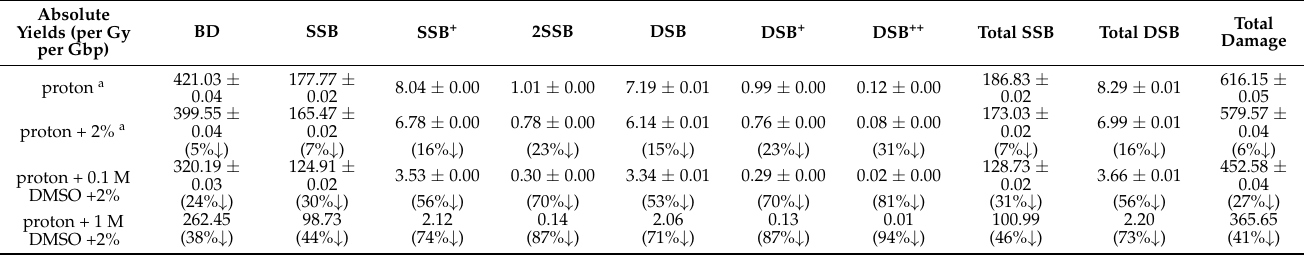
Table 3. Absolute Yields of DSB Inductions for Cells Irradiated with Proton Ions (LET = 1.051 keV/ µ m) under 2% Oxygen (O 2 ) and at Various Concentrations of DMSO.